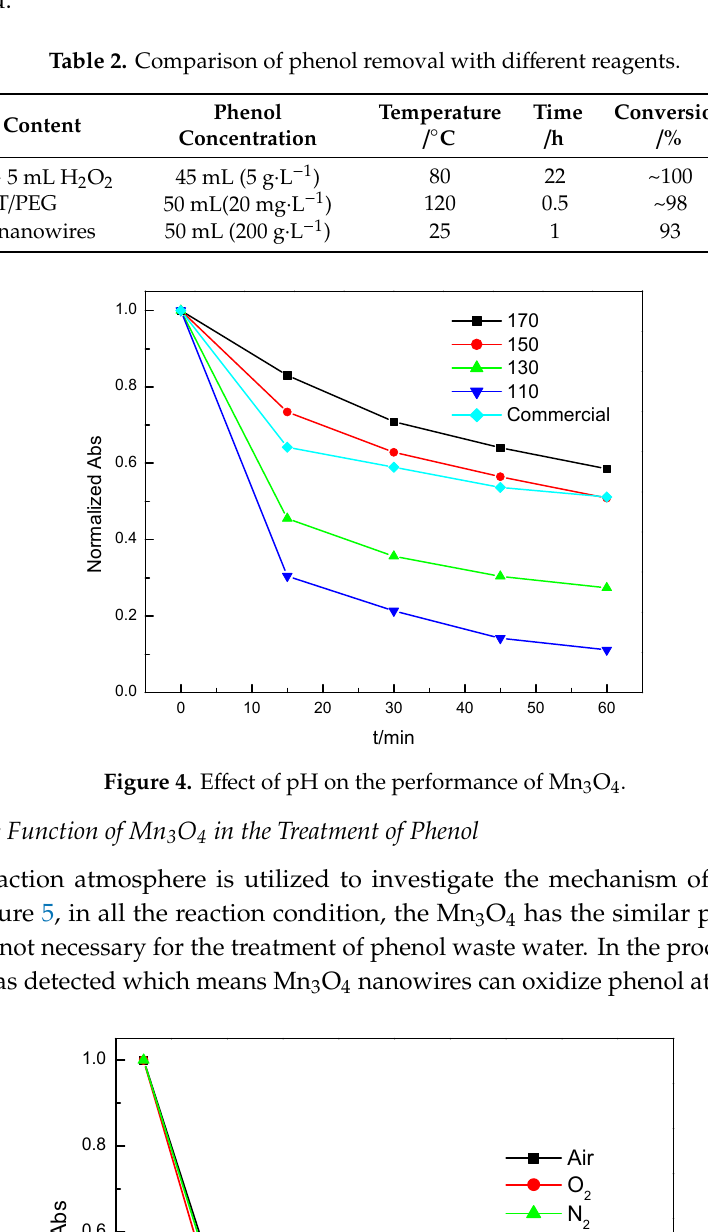
Figure 6. Effect of reaction time on the concentration of hydroquinone and benzoquinone. Benzoquinone and hydroquinone are the common oxidation products of phenol. In this work, pure benzoquinone and hydroquinone solutions are used as the waste water separately, while 20 mg Mn 3 O 4 is added in the 50 mL solution (pH = 2, adjusted with H 2 SO 4 ). After 5 min, about 60% hydroquinone is converted to benzoquinone as shown in Figure 6. It was also found that the solution is changed into yellow (the color of benzoquinone) while all Mn 3 O 4 nanowires are dissolved which demonstrates that hydroquinone can react with the nanoparticles efficiently. For the benzoquinone